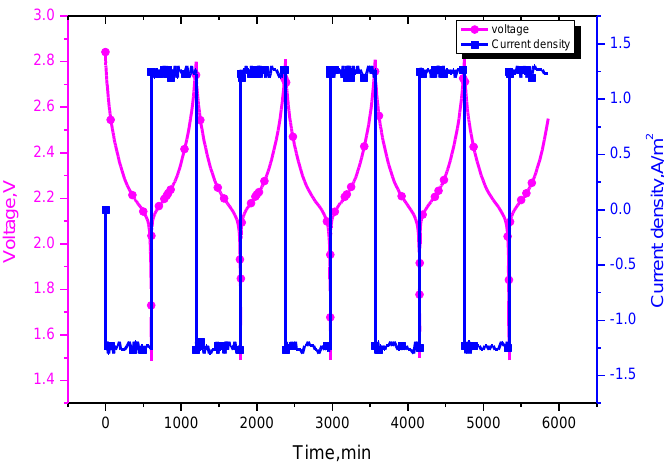
Figure 3. The profile of voltage and current density at 0.1 C cycling.